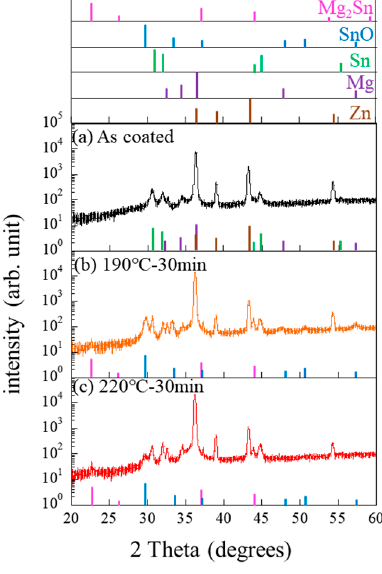
Figure 5. XRD patterns of Sn/Mg films. ( a ) As coated, ( b ) 190 °C for 30 min and ( c ) 220 °C for 30 min.